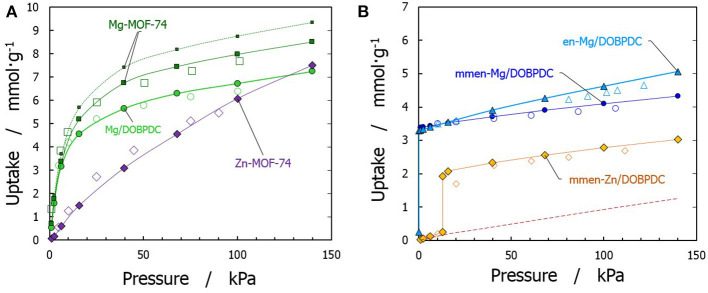
Validation of simulated (filled symbols) adsorption isotherms of carbon dioxide with available experimental data (open symbols) for (A) bare materials [squares from Mason et al. (2011), at 313 K; circles from McDonald et al. (2015), at 298 K; diamonds from Caskey et al. (2008), at 296 K], and (B) functionalized materials [triangles from Lee et al. (2014), at 298 K; circles and diamonds from McDonald et al. (2015), at 313 K]. Lines are to guide the eyes. For bare Mg-MOF-74, dotted line represents pristine material and straight line is the isotherm after using a scaling factor according to Dzubak et al. (2012).